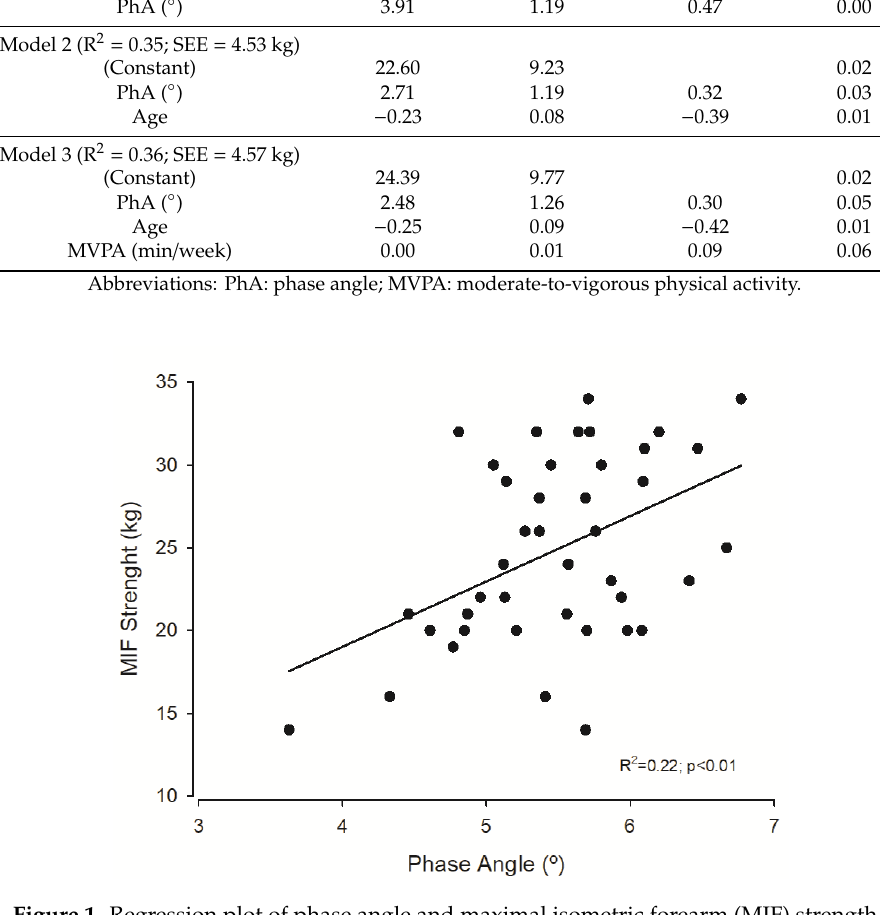
Figure 1. Regression plot of phase angle and maximal isometric forearm (MIF) strength.